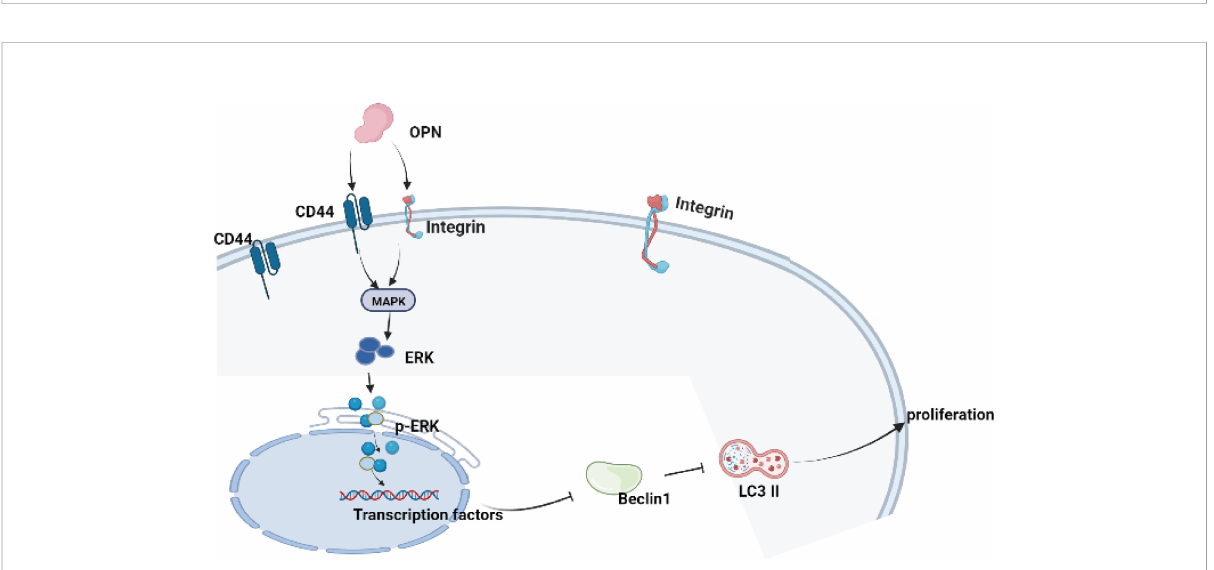
FIGURE 7 The schematic diagram of the present research indicated that OPN combined with CD44 and integrin inhibits autophagy activity through the MAPK signaling pathway in